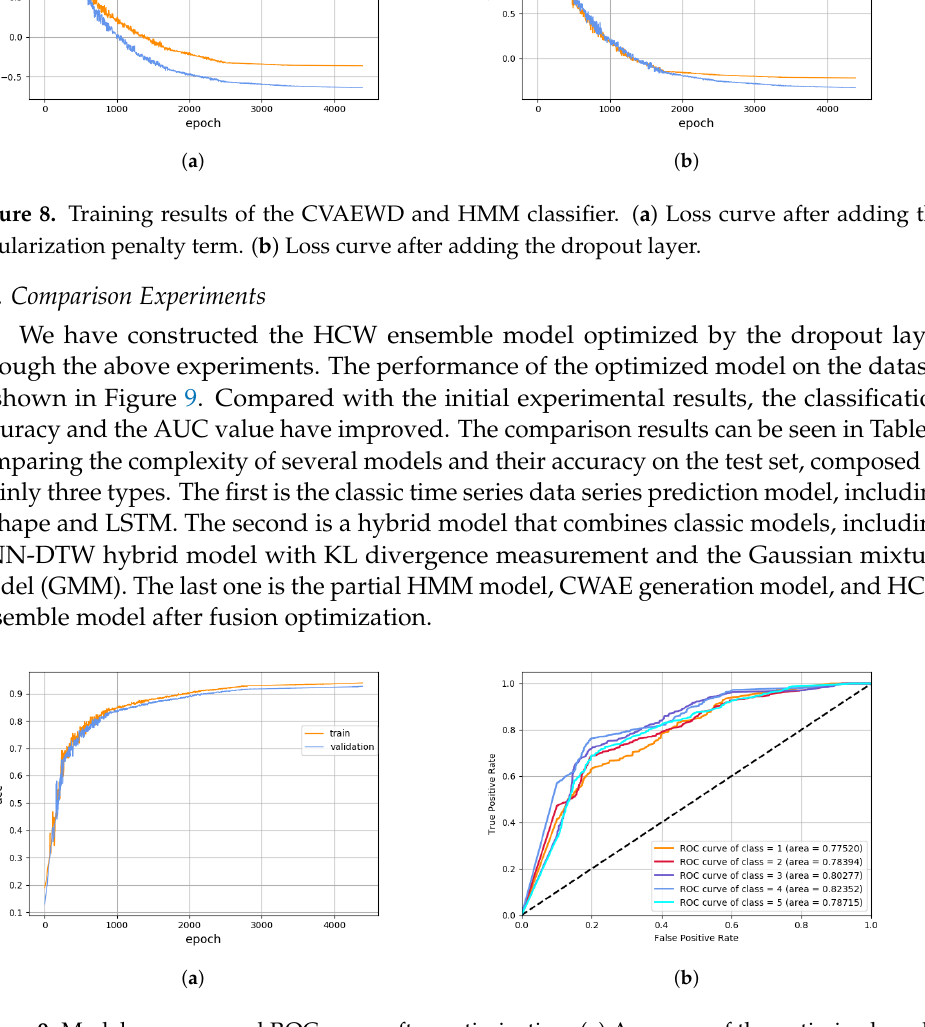
Figure 9. Model accuracy and ROC curve after optimization. ( a ) Accuracy of the optimized model. ( b ) ROC curve of the optimized